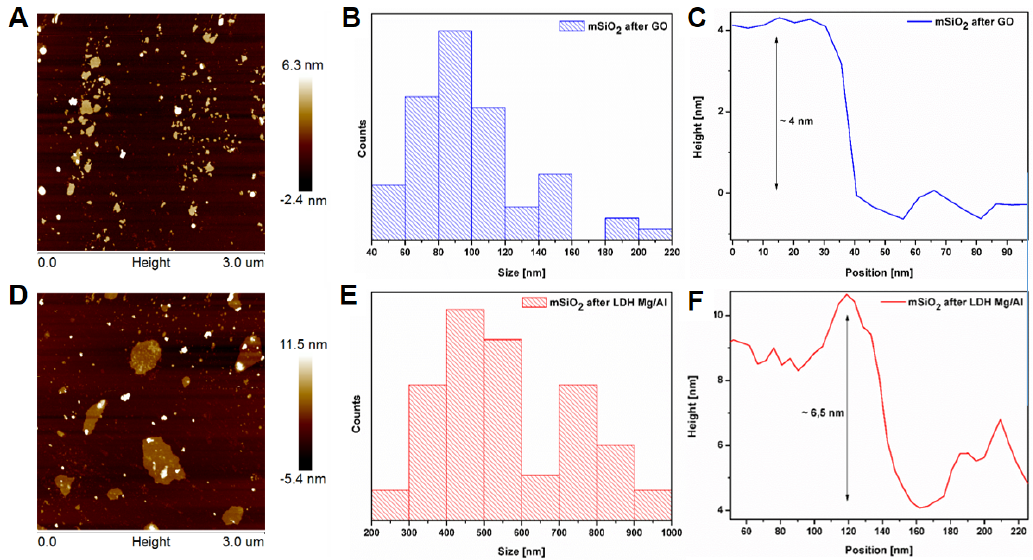
Figure 2. Atomic force microscopic images ( A , D ), flakes size distributions ( B , E ), and height profiles ( C , F ) of selected mSiO 2 after GO (upper panel) and mSiO 2 after LDH Mg/Al (lower panel).